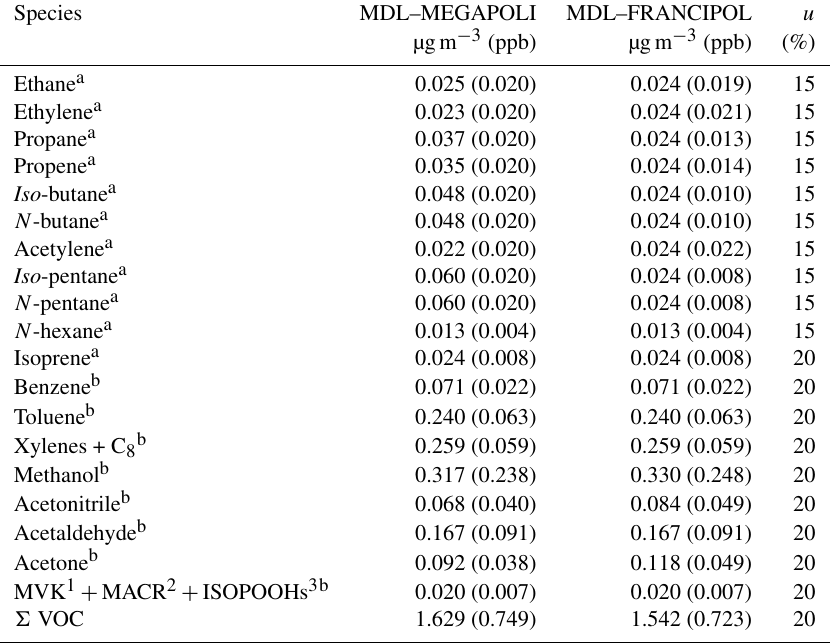
Table A1. MDLs and analytical uncertainties ( u ) for each species used in PMF modeling simulations. Species MDL–MEGAPOLI MDL–FRANCIPOL u µgm − 3 (ppb) Ethane a Propane a Propene a 0.035